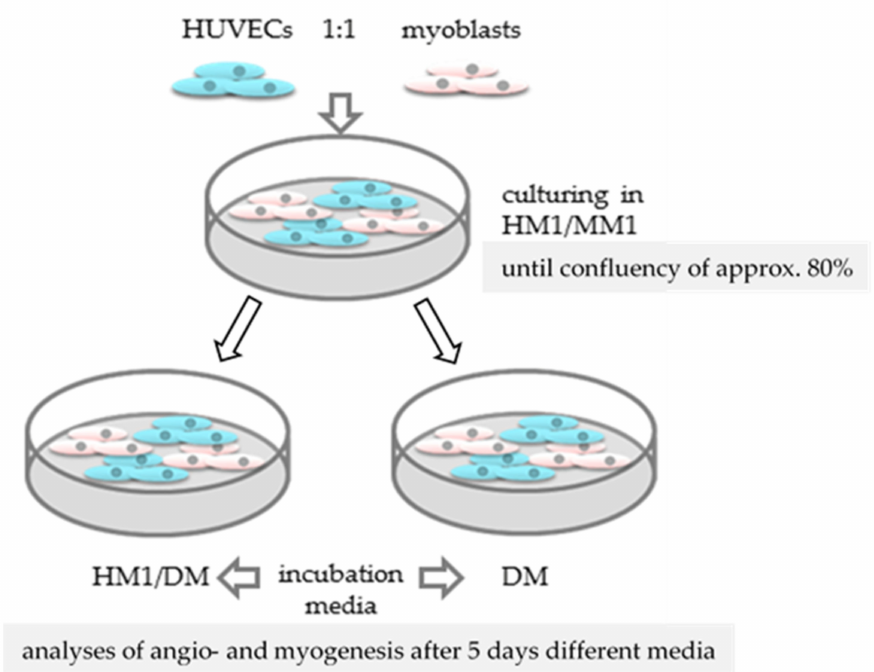
Figure 11. Experimental design of the co-culture evaluation with primary human myoblasts and